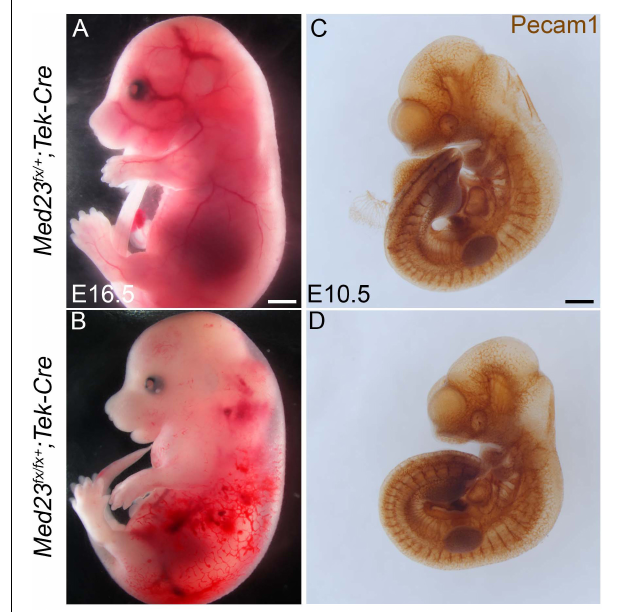
FIGURE 8 | Conditional deletion of Med23 in endothelial cells. (A,B) Brightfield images of E16.5 Med23 fx / + ;Tek-Cre and Med23 fx / fx ;Tek-Cre embryos indicate that the mutant embryos exhibit severe hemorrhaging and edema, probably resulting in lethality. (C,D) Immunostaining for endothelial cells using PECAM1 suggests development in Med23 fx / fx ;Tek-Cre embryos is normal. Scale bars for (A,B) is 450 um, (C,D) is 300